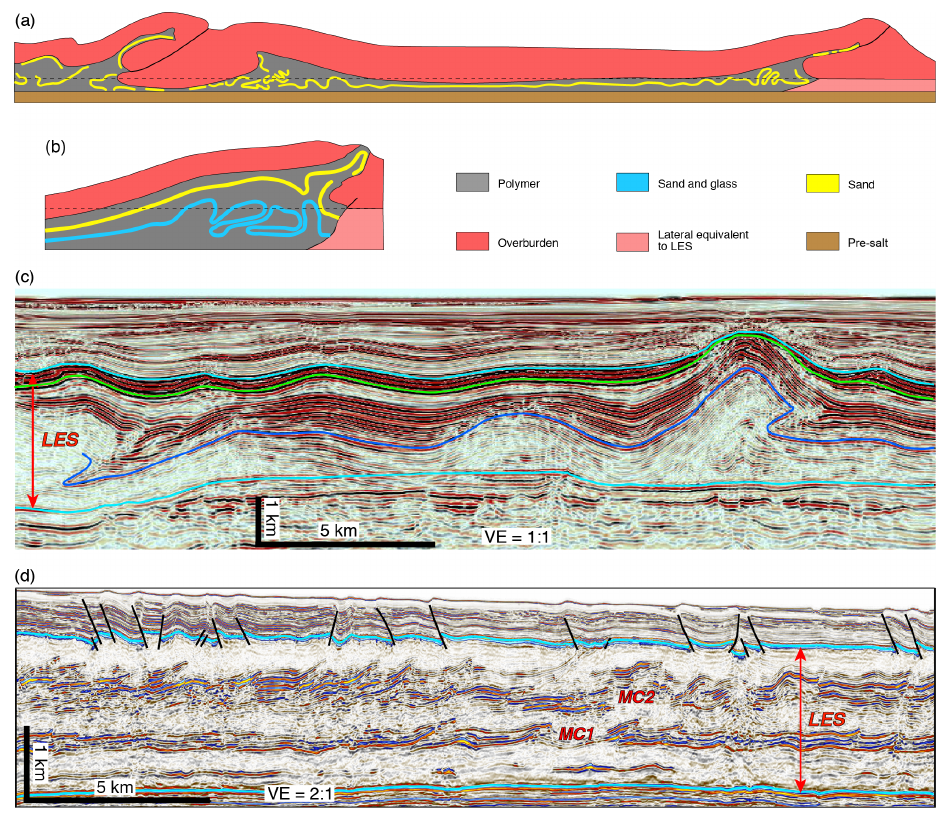
Figure 7. Examples of layer-parallel shortening of salt with internal competent beds: (a) simplified results of analog model of shortening detached on polymer layer with a thin interbed of competent sand (yellow) located at the middle level of the polymer – the black dashed line shows the original top polymer, and the intra-polymer layer forms tight to isoclinal folds that have been partially disrupted (adapted from Pla et al., 2019); (b) simplified results of analog model showing shortened and inflated polymer (this is the other half, but reversed, of the model shown in Fig. 4a) – the black dashed line shows the original top polymer, and the yellow and blue layers are stronger intra- polymer layers, with more contraction at the deeper, blue level (adapted from Cartwright et al., 2012; model by Tim P. Dooley); (c) 3-D depth-migrated seismic profile from the Santos Basin (vertical exaggeration 1 : 1) with a gently folded LES (between the cyan horizons) and cover – the deep (blue) intrasalt level is shortened more than the shallow (green) level, but this is not due to progressive deformation during evaporite deposition (modified from Fiduk and Rowan, 2012); (d) 3-D depth-migrated seismic profile (vertical exaggeration 2 : 1) from the Levant Basin showing the mostly tabular Messinian evaporites (LES, between the cyan horizons) with only minor folding of the cover – the shallower MC2 intrasalt sequence (see Fig. 1e) is shortened more than the MC1 level (modified from Feng et al.,